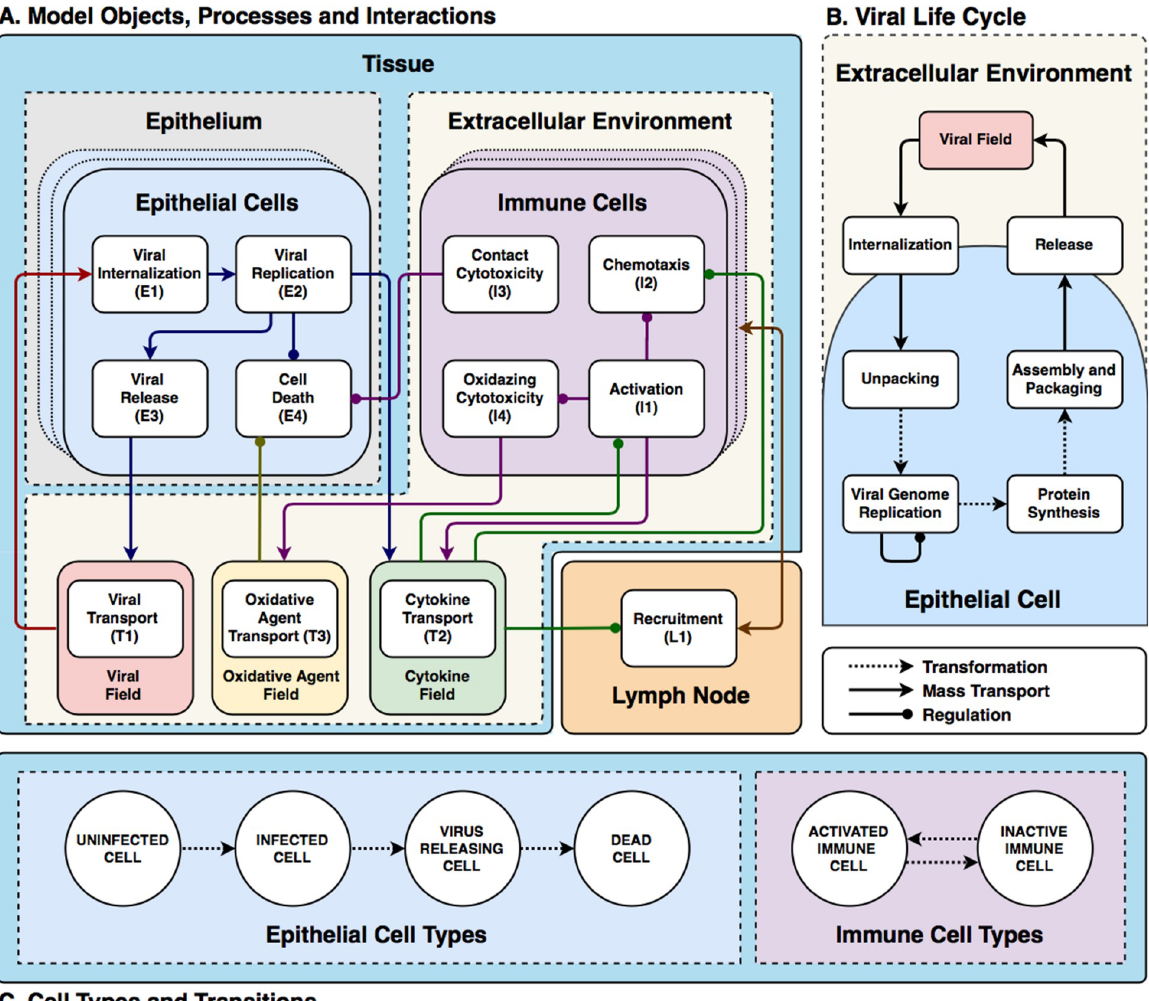
Fig 2. Full model schematic. (A) Model objects, processes and interactions: Conceptual model of an epithelial tissue and lymph node. Schematic representation of the model objects, processes and interactions. Epithelial and immune cells refer to the two main classes of cells. Interactions occur within an extracellular environment, and a compartmental model of a lymph node controls immune-cell recruitment to the tissue. Together the epithelial-cell, extracellular-environment and immune-cell components represent the epithelial tissue. Each model object has associated processes that dictate its states and behaviors. Epithelial-cell processes include viral internalization ( E1 ), viral replication ( E2 ), viral release ( E3 ) and cell death ( E4 ). Immune cell processes include activation ( I1 ), chemotaxis ( I2 ), contact cytotoxicity ( I3 ) and oxidative cytotoxicity ( I4 ). Activated immune cells participate in oxidative cytotoxicity ( I4 ) and secrete oxidative agents into the oxidizing-agent field ( T3 ). Activated cells become inactive after 1 hour. The virus field ( T1 ), cytokine field ( T2 ) and oxidizing-agent field ( T3 ) describe spatially-varying densities of extracellular components. Field processes describe diffusive transport and clearance of material in the extracellular environment and activated transport to the lymph nodes. The lymph node is a single-compartment model whose pro- or anti-inflammatory state specifies the recruitment or removal rate ( L1 ) of immune cells in the epithelial tissue. The transport of cytokines to the lymph node promotes its proinflammatory state. (B) Viral Life Cycle: Interactions in the viral internalisation, replication and release models. Schematic representation of inputs, outputs and interactions between stages of the viral replication model. Extracellular viral particles (represented as continuous fields) are internalized by the viral internalization model and initiate the viral replication model. The main stages of the viral replication model are: unpacking, viral genome replication, protein synthesis and viral assembly and packaging. The output of the viral replication model passes to the viral release model, which transfers newly assembled viral particles from the cells into the extracellular environment. (C) Cell types and transitions. Epithelial cells are of type uninfected if they have not yet internalized any virus ( E1 ). They are of type infected if they have internalized virus, but are not releasing virus into the virus field (viral release E3 is inactive). They are of type virus releasing if they are releasing virus into the extracellular virus field ( i . e ., viral release E3 is activated). Immune cells are initially inactive and do not participate in the oxidative cytotoxicity ( I4 ) or chemotax towards higher concentrations of the cytokine field ( I2 ). They become activated when they experience activation ( I1 ). In all panels, dashed arrows with barbed heads represent transformations, solid arrows with barbed heads represent transport and solid arrows with lollipop heads represent regulation.